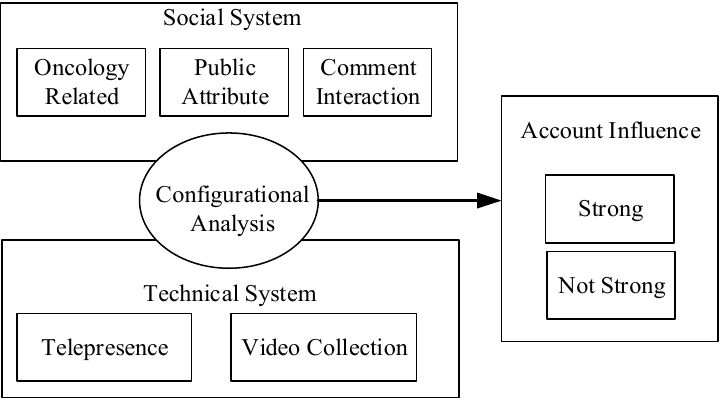
Figure 1. Research mode.